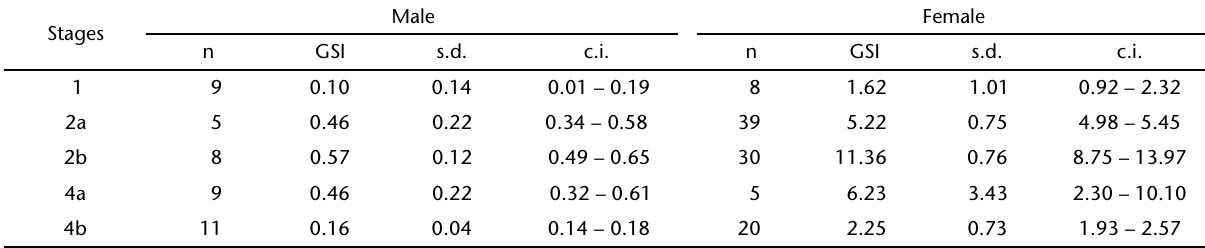
Table II. Gonadosomatic index averages (GSI) for Hypostomus affinis by sex in different stages of gonadal development. Values of standard deviation (s.d.), confidence interval (c.i.), and number of examined individuals (n) also showed. Stages